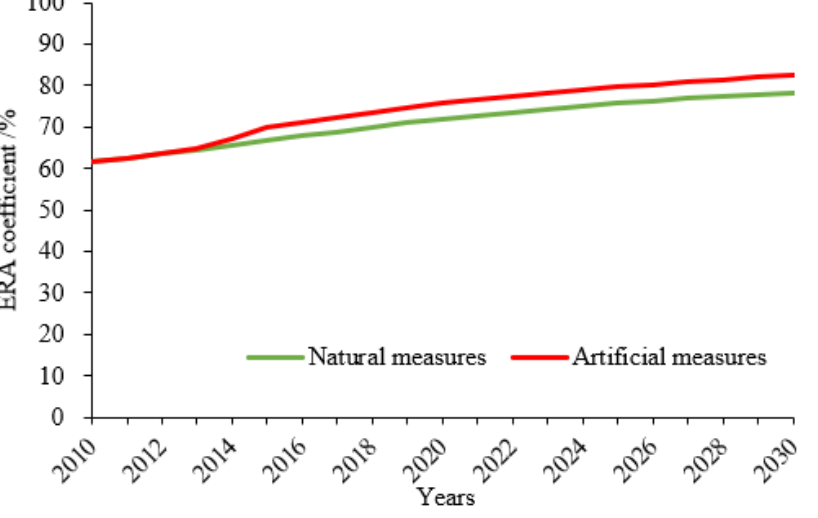
Figure 6. ERA coefficients of natural and artificial restoration measures in the Upper Zagunao watershed from 2010 to 2030. Table 4. Forest changes under natural and artificial restoration